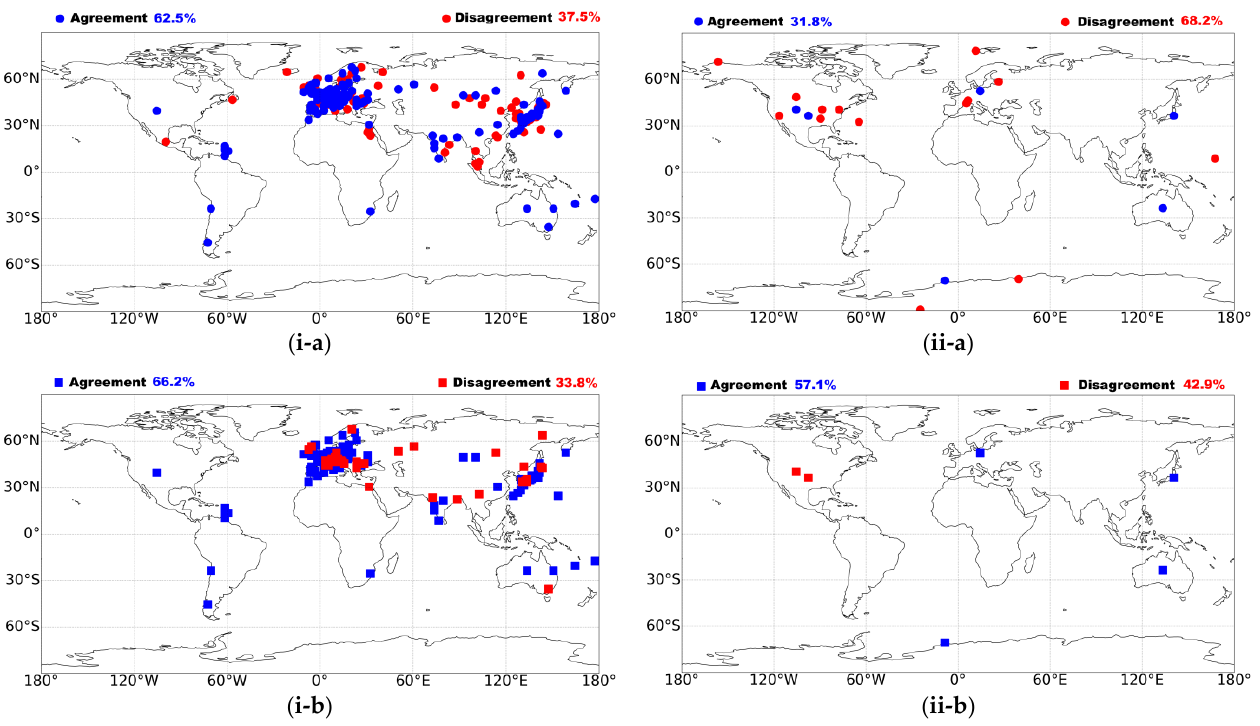
Figure 10. Agreement (blue dots) and disagreement (red dots) between trends of MERRA-2 and station deseasonalized SSR anomalies ( Δ (SSR)), for GEBA ( i-a ) and BSRN ( ii-a ) stations for the period 07/2000 – 06/2017. The stations showing agreement at the surface against GEBA stations ( i-a ) and BSRN stations ( ii-a ), also having agreement of Δ (OSR) with CERES at TOA, during the same period, are shown in ( i-b ) and ( ii-b ), respectively.